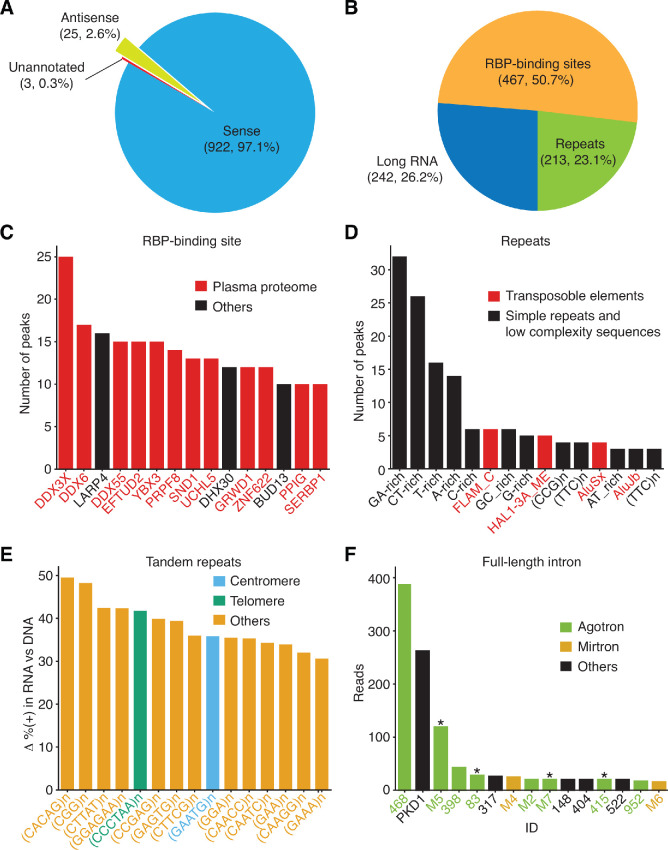
Peak-calling analysis of plasma RNA.The MACS2 algorithm was used to call peaks in combined TGIRT-seq datasets for DNase-treated plasma RNA (n = 15) after removal of the reads for rRNAs, Mt RNAs, and annotated sncRNAs (tRNAs, Y RNAs, 7SK and 7SL RNAs, vault RNAs, snoRNAs, snRNAs, high confidence miRNAs, and miscellaneous RNAs). The combined datasets for NaOH-treated plasma DNA (n = 4) were used as the base-line control. Only peaks with q-value < 0.05 assigned by MACS2 and supported by alignments from at least five separate libraries at the peak summit were used for the analysis. Peaks were intersected sequentially with (i) binding sites for 109 RNA-binding protein (RBPs) from ENCODE K-562 and HepG2 cell eCLIP datasets; (ii) RefSeq and GENCODE gene annotations; and (iii) repeat annotations from Repbase, and a best feature annotation for each peak was selected by the highest overlap score, as described in Materials and methods. (A) and (B) Pie charts showing the proportion of peaks with annotations on the sense strand, antisense strand, or no annotations (A) and the proportion of peaks mapping to different categories of genomic features with sense-strand annotations (B). The number of peaks in each sector and their percentage of the total are indicated in parentheses. (C–F) Bar graphs showing the (C) top 15 RBP-binding sites ranked by peak count, with RBPs found to be part of the plasma proteome (Nanjappa et al., 2014) shown in red; (D) top 15 Repbase annotated repeats ranked by peak count, with simple repeats and low complexity sequences in black and transposable element RNAs in red; (E) top 15 short tandem repeat RNAs with highest difference (Δ) in the percentage of (+) orientation reads between the DNase-treated plasma RNA and NaOH-treated plasma DNA datasets color coded as indicated in the Figure; (F) top 15 peaks corresponding to full-length excised intron RNAs ranked by the number of deduplicated reads. The peak IDs are indicated on the x-axis and are color-coded by annotated intron RNA type: agotron (green); mirtron (gold); annotated as both agotron and mirtron (green with asterisk). Others, not annotated in the previous categories (black). The read count for PKD1 is the combined count from the peak in PKD1 gene and the peaks for the same intron in six PKD1 pseudogenes (Figure 9D below and peak IDs #335–340).